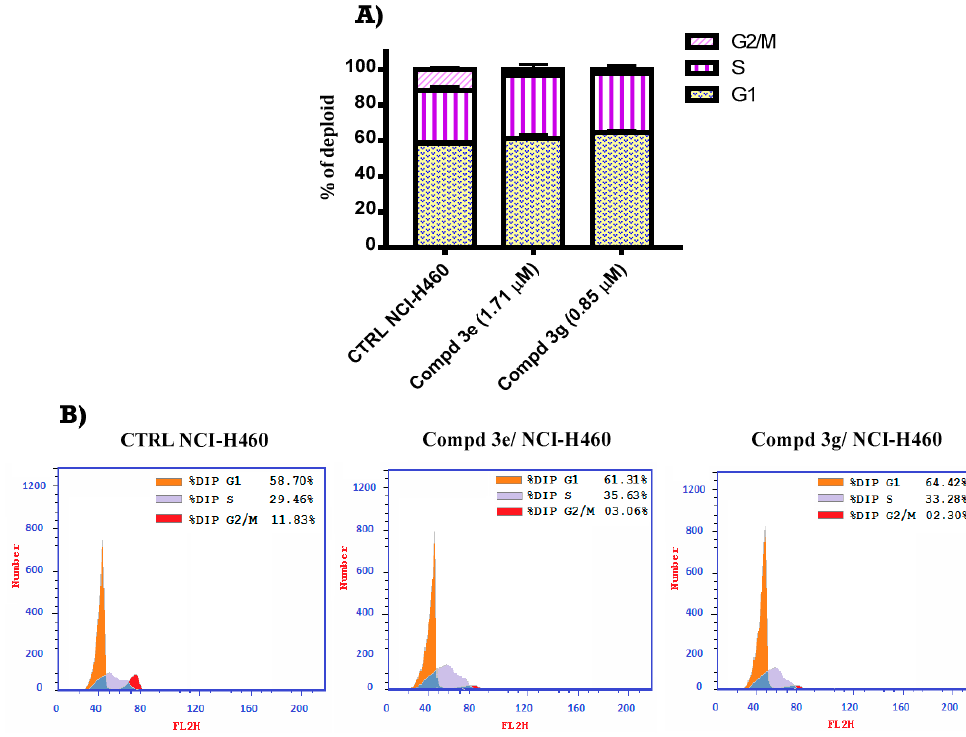
Figure 3. ( A ) FACS analysis of cell cycle distribution percentage of NCI-H460 cells after treatment with compounds 3e and 3g at their IC 50 ( μ M) for 24 h relative to untreated control. ( B ) Graphical representation of FACS analysis of cell cycle distribution percentage of NCI-H460 cells after treatment with compounds 3e and 3g at their IC 50 ( µ M) for 24 h relative to untreated